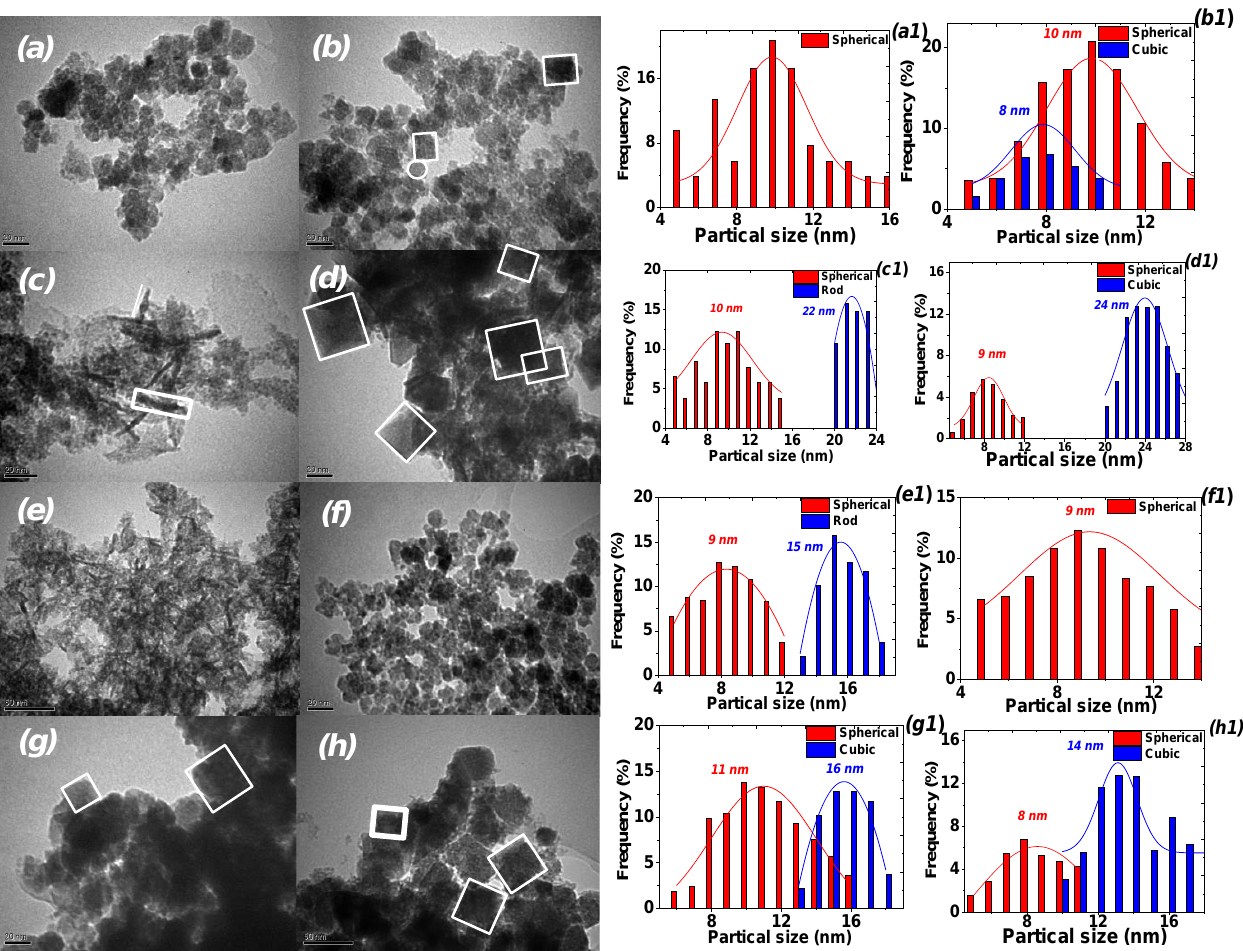
Figure 3. TEM images and particle size distribution of MNPs obtained with EtOH extract of control leaves ( a , a1 — № 1), roots ( b , b1 — № 2) and “hairy” roots of Artemisia tilesii ( c – h , c1 – h1 — № 3–8) after addition to the FeCl 3 /FeSO 4 /CoCl 2